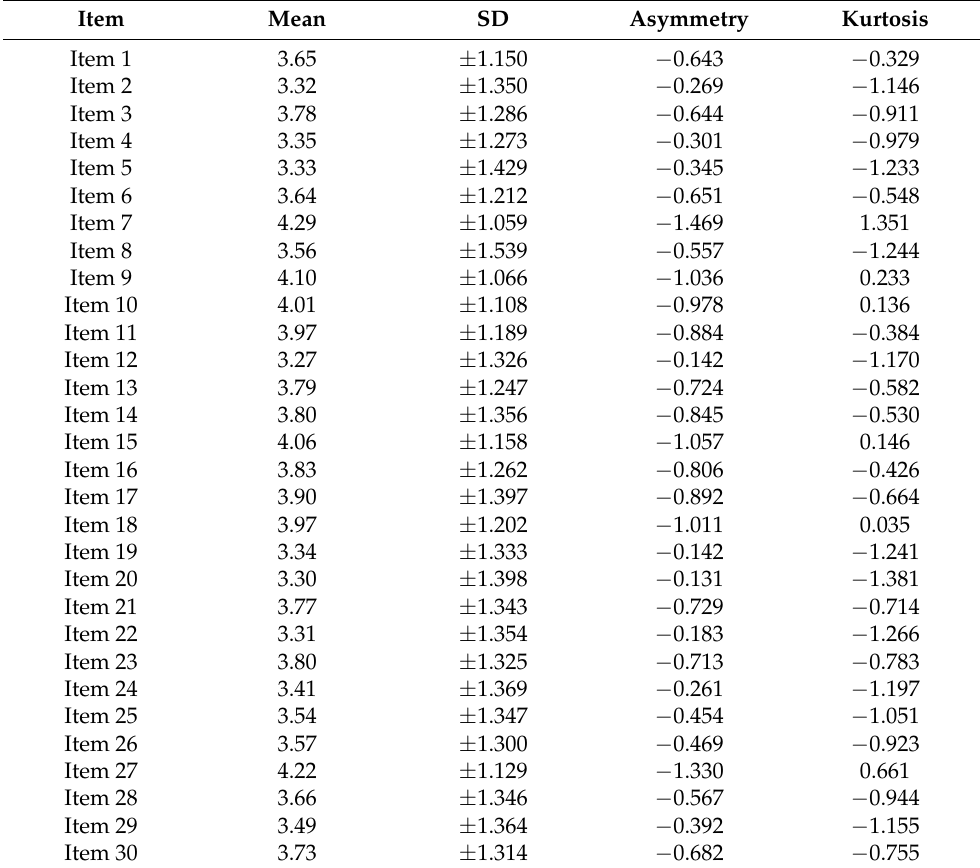
Table 2. Descriptive statistics of the items of SSS-W-E.